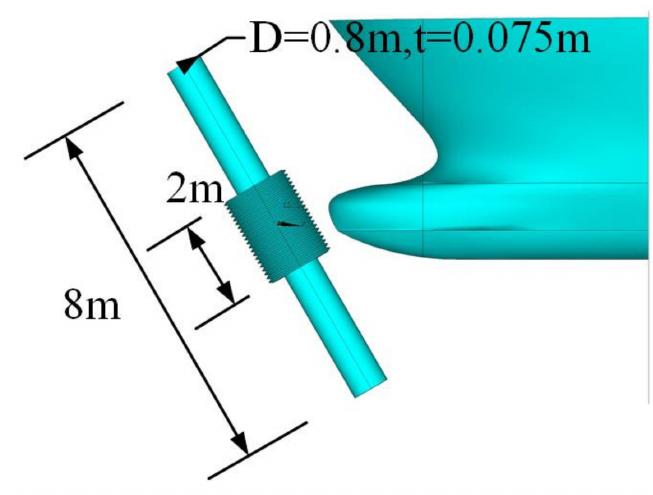
Figure 7. Diagrammatic sketch of the honeycomb reinforced pipe.